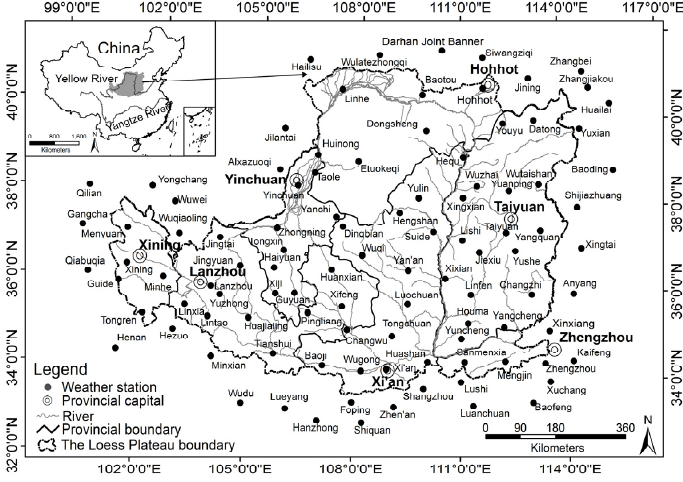
Figure 1. Location of the study site and distribution of weather stations.